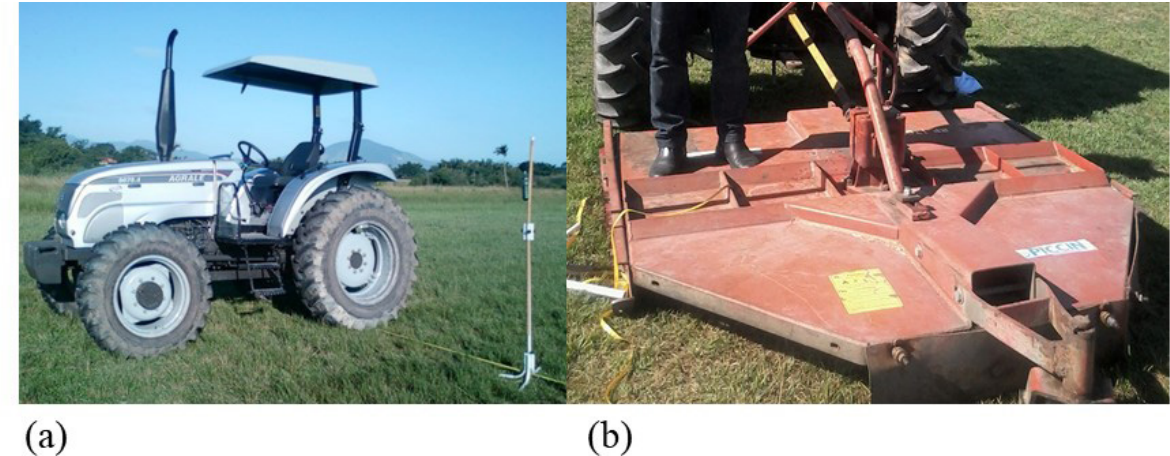
Figure 1. Agricultural tractor measured for noise levels: a) without activation of a rotary cutter; b) with activation of a rotary